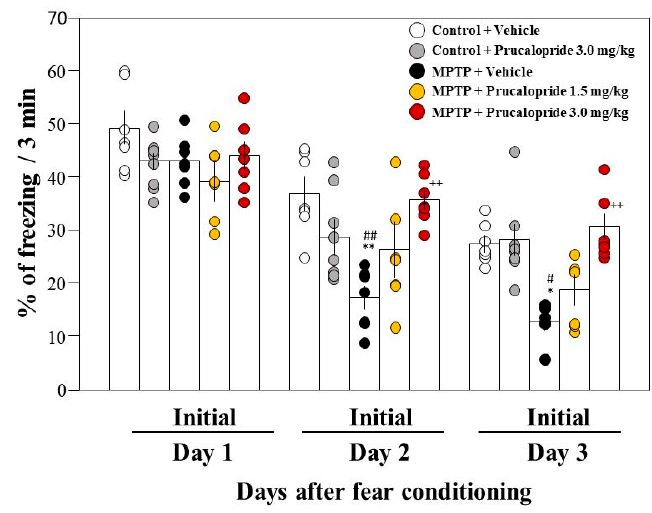
Figure 1. Effects of prucalopride on contextual fear extinction in mice. Mice were given an intraperitoneal injection of prucalopride at a dose of 1.5 or 3.0 mg/kg in saline containing 1% dimethyl sulfoxide (DMSO )or the vehicle only 2 h prior to both extinction training sessions. Data are expressed as the mean ± SEM; n = 7–8. * p < 0.05 and ** p < 0.01 vs. control + vehicle on each day, ++ p < 0.01 vs. MPTP + vehicle on each day, # p < 0.05 and ## p < 0.01 vs. control + prucalopride on each day (one-way analysis of variance (ANOVA) followed by Tukey’s post-hoc test). MPTP: